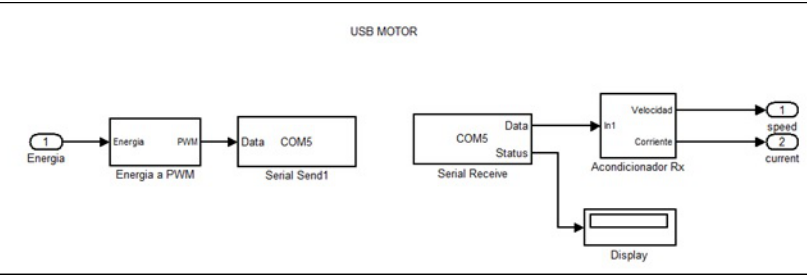
Figure 19. “USB Motor” block